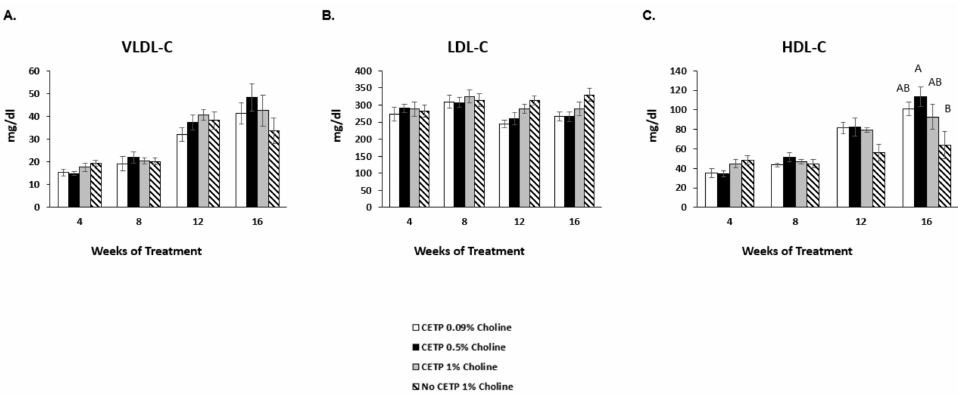
Figure 4. Effects of TMAO on lipoprotein particle distribution in vivo. Apoe − / − mice expressing CETP or controls (no CETP) were fed chow with supplementation of low, moderate and high choline for 16 wk. Blood was collected at 4, 8, 12 and 16 weeks of treatment. Plasma lipoproteins ( A ) VLDL-C, ( B ) LDL-C and ( C ) HDL-C were determined by gel electrophoresis using SPIFE3000 and a Cholesterol-Vis kit. The results are expressed as the mean ± SEM from 11–12 animals/group. A one-factor ANOVA test was used to analyse normally distributed data, and a Kruskal–Wallis test was performed for non-normally distributed data. Post hoc Tukey’s honestly significant difference test (HSD) pairwise comparisons were conducted to identify statistical differences between the treatment groups when a significant main effect was found. Means that do not share a letter are considered significantly different; p < 0.05. TMAO: trimethylamine N-oxide; CETP: cholesterol ester transfer protein; VLDL-C: very low density lipoprotein-cholesterol; LDL-C: low density lipoprotein- cholesterol; HDL-C: high density